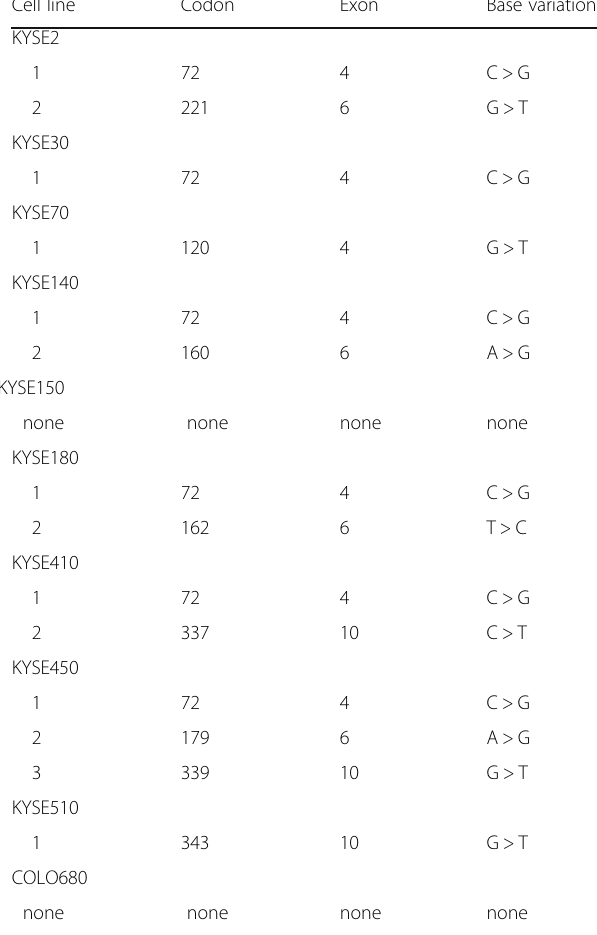
Table 3 Sequenced and assessed TP53 mutations in Ten ESCC cell lines. Only KYSE150 and COLO680 express the WT